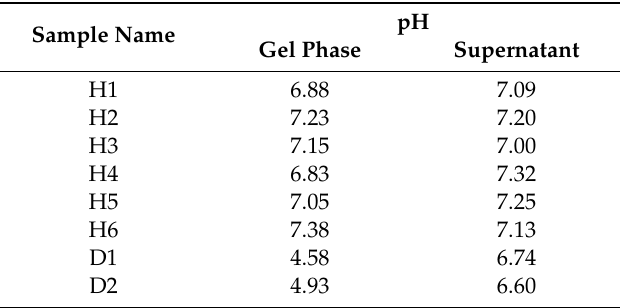
Table 3. pH values of hydrogels and